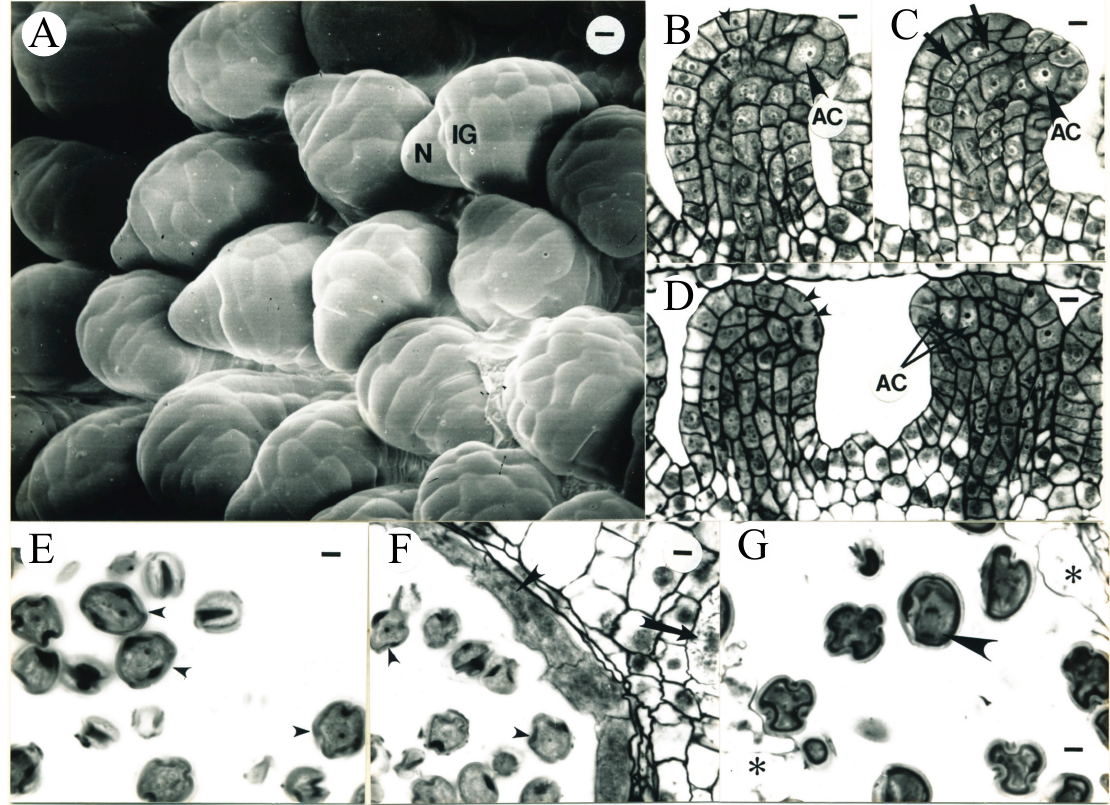
Figure 8. Tobacco ovule and anther development during the 13th day after ECP ( A – F ) and anther development during the 14th day after ECP ( G ). ( A ) SEM micrograph of representative ovules from the age interval 12.9 ± 1.2 days after ECP. The distal end of each ovule begins to recurve. Nucellus (N) and integument (IG) are evident. Bar = 6.7 µ m. ( B – D ) Longitudinal sections of ovules similar to those seen in ( A ). ( B ) The evident archesporial cell (AC, larger arrowhead) in the subepidermal layer of the ovule. Integument initiation is associated with periclinal divisions in L1 of the ovule (smaller arrowhead). Bar = 7.6 µ m. ( C ) Recent periclinal divisions in L2 at the recurving end in the ovule (arrows). AC, archesporial cell. Bar = 7.6 µ m. ( D ) Two ovules showing twin archesporial cells (AC) observed in a single ovule and periclinal divisions (arrowheads) observed in the L1 layer of the other ovule. Bar = 8.2 µ m. ( E ) Microspores (arrowheads) shown in the anthers with the average flower age of 12.9 ± 1.2 days after ECP. Bar = 5.5 µ m. ( F ) The degrading outer tapetum (larger arrowhead) with microspores (smaller arrowheads) observed as those in ( E ). CCC cells contain crystals (arrow) and have lost staining color. Bar = 6.5 µ m. ( G ) Mitotic divisions in anaphase (arrow) observed in microspores with the average flower age of 14.0 ± 1.2 days after ECP. Remnants of tapetum (asterisks) are still present. Bar = 6.1 µ m.